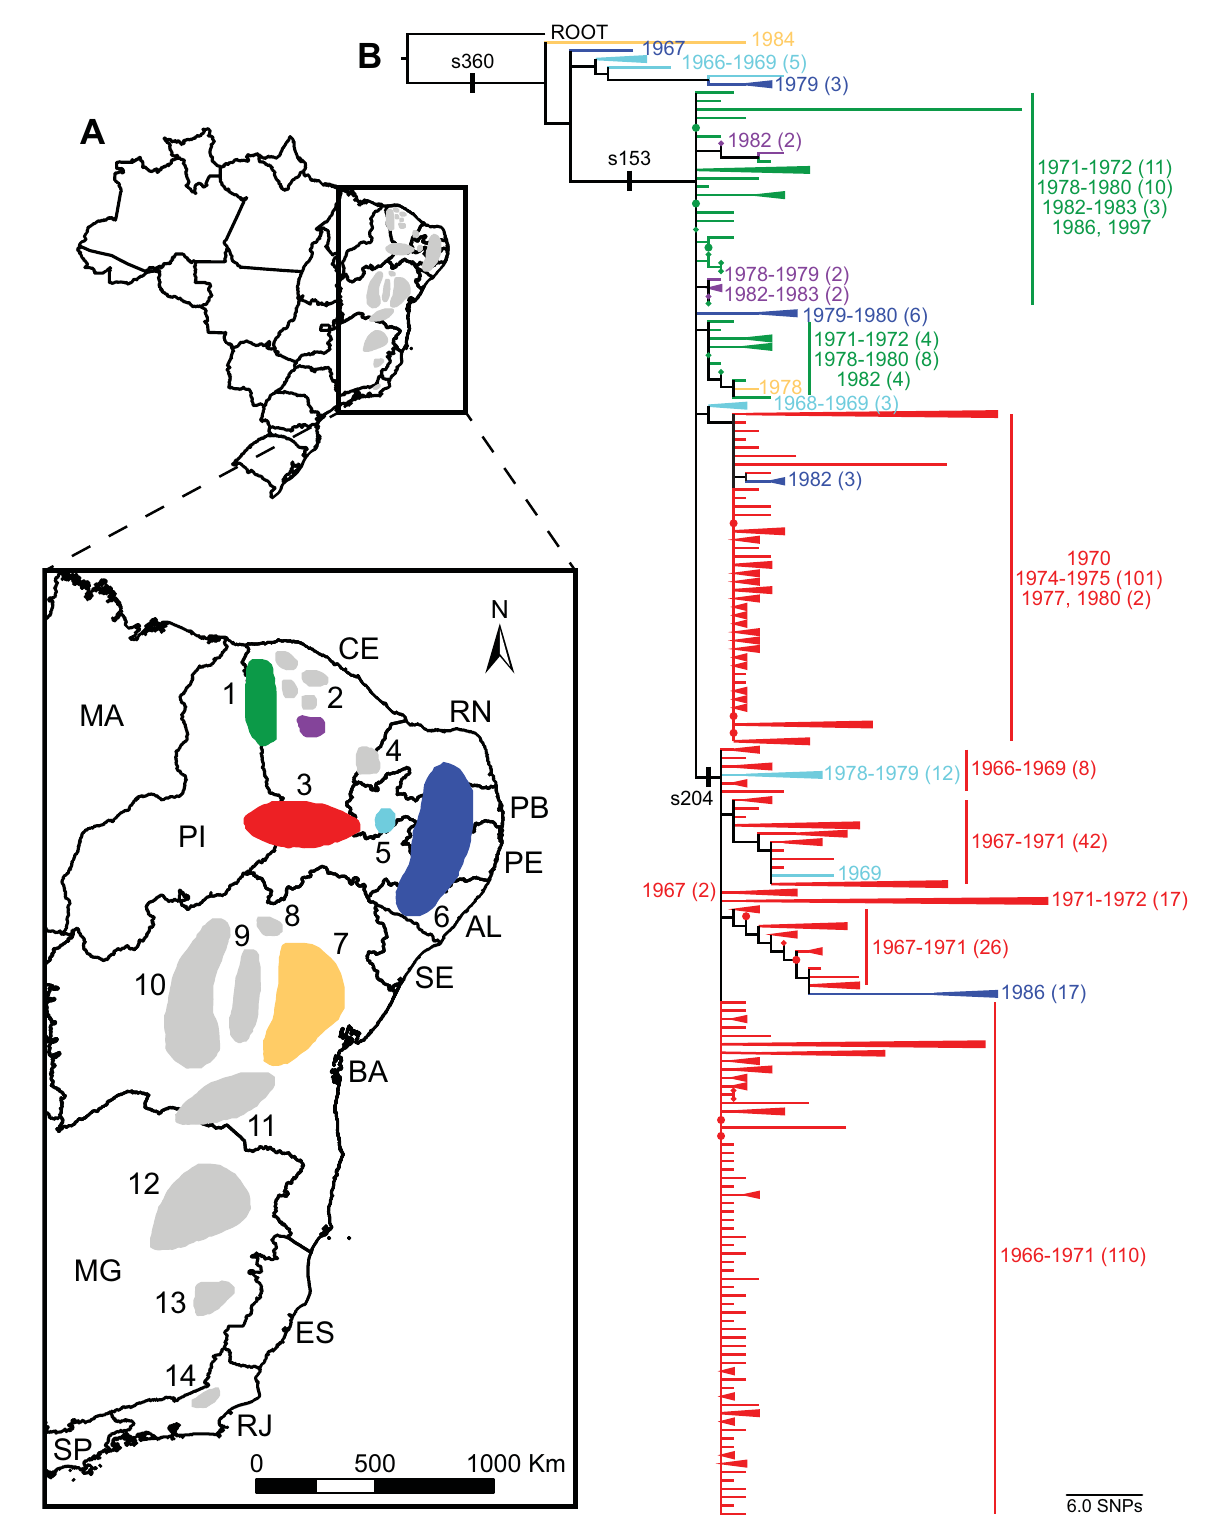
Fig 2. Phylogeography of Yersinia pestis in Brazil. (A) Map indicating recognized plague foci in Brazil. The six foci represented in this study are shown in color with unrepresented foci in gray. Foci are as follows: 1) Serra de Ibiapaba (green), 2) Serra das Matas, de Baturite´ (purple), de Pedra Branca, do Machado, and de Uruburetama, (these five smaller foci are sometimes grouped together as a single focus) 3) Chapada